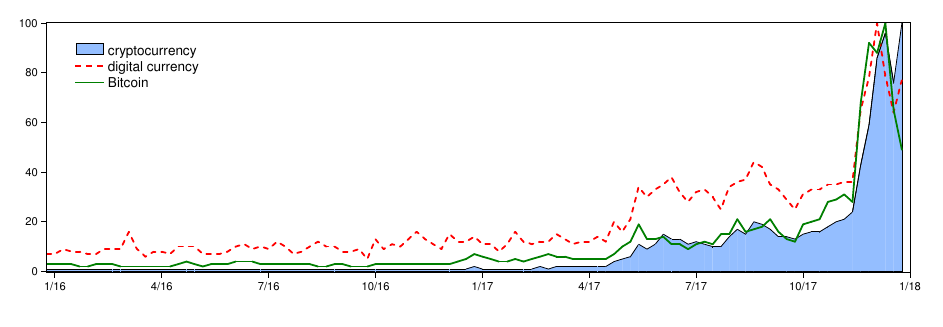
Figure 4. Google Trends Index Since